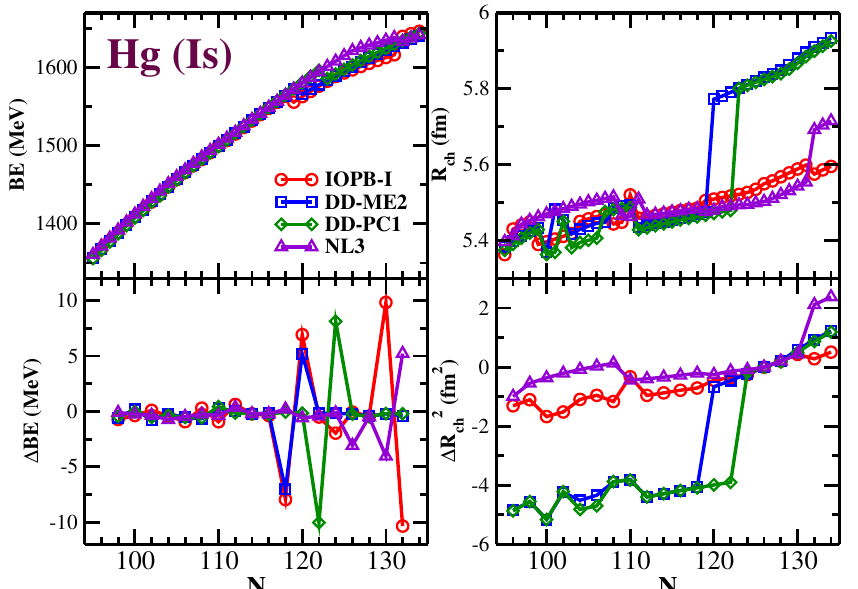
Figure 3. (Color online) The binding energy (BE) and charge distribution radius ( R ch ) are shown along with their respective shifts ( ∆ BE , ∆ R 2 ) for the isomeric state of Hg-isotopes. The energies in ch MeV and radius in